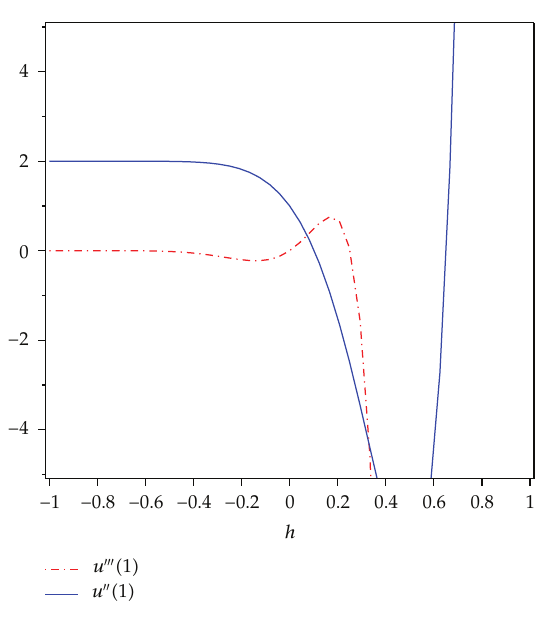
Figure 3: 11th-order HAM h -curve. Table 2: Numerical result of Example 5.1 against the SHAM solutions whit h (cid:8) − 0 .